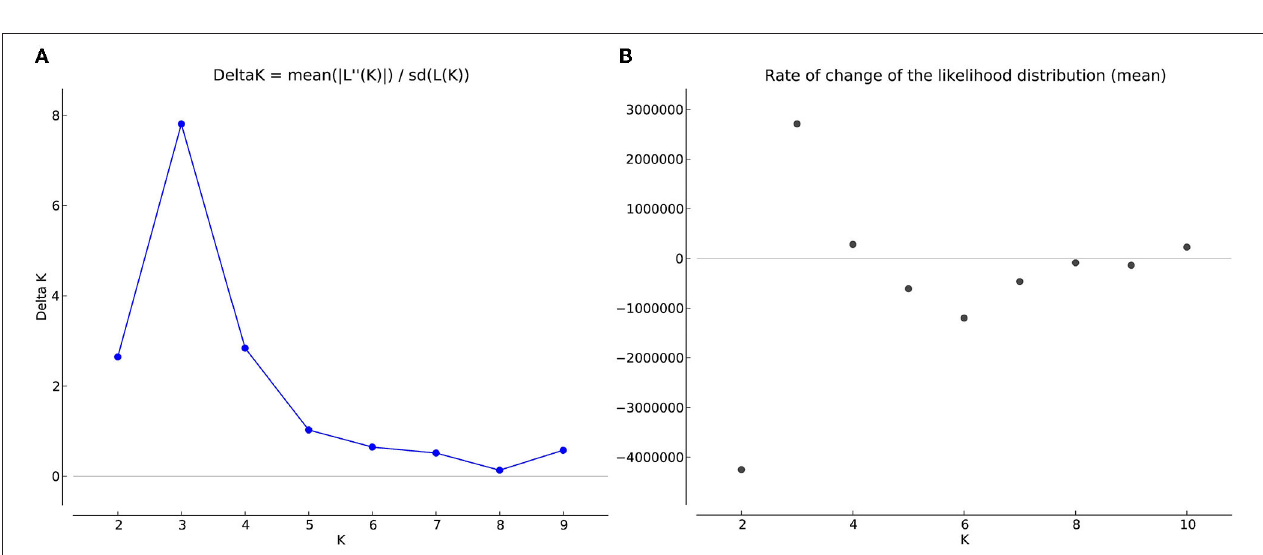
FIGURE 5 | The distribution of minor allele frequencies of the discovered SNPs shows Strong skew toward rare alleles (alleles with frequency <0.1%).